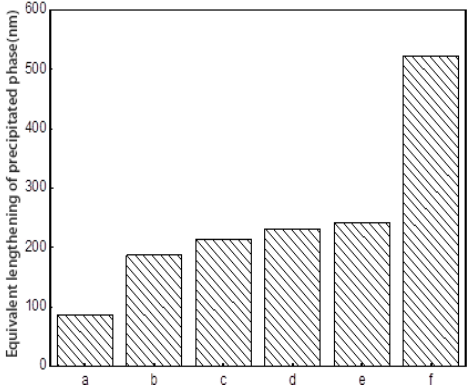
Figure 8. Equivalent side lengths of the precipitated phase under different aging treatment